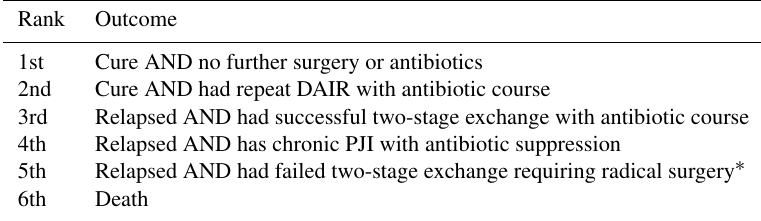
Table 4. Preferred ranking order from specific ranking experiments. Rank Outcome 1st Cure AND no further surgery or antibiotics